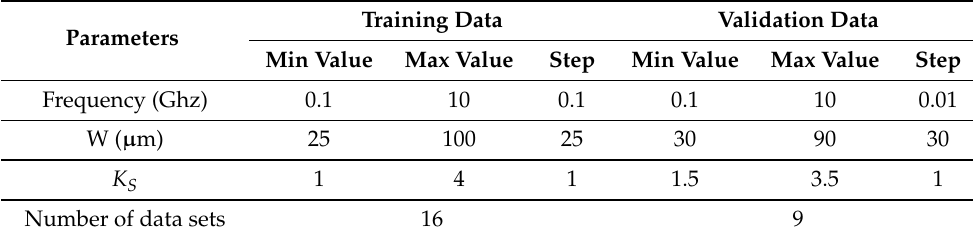
Table 4. Training and validation data information of the stripline structure.